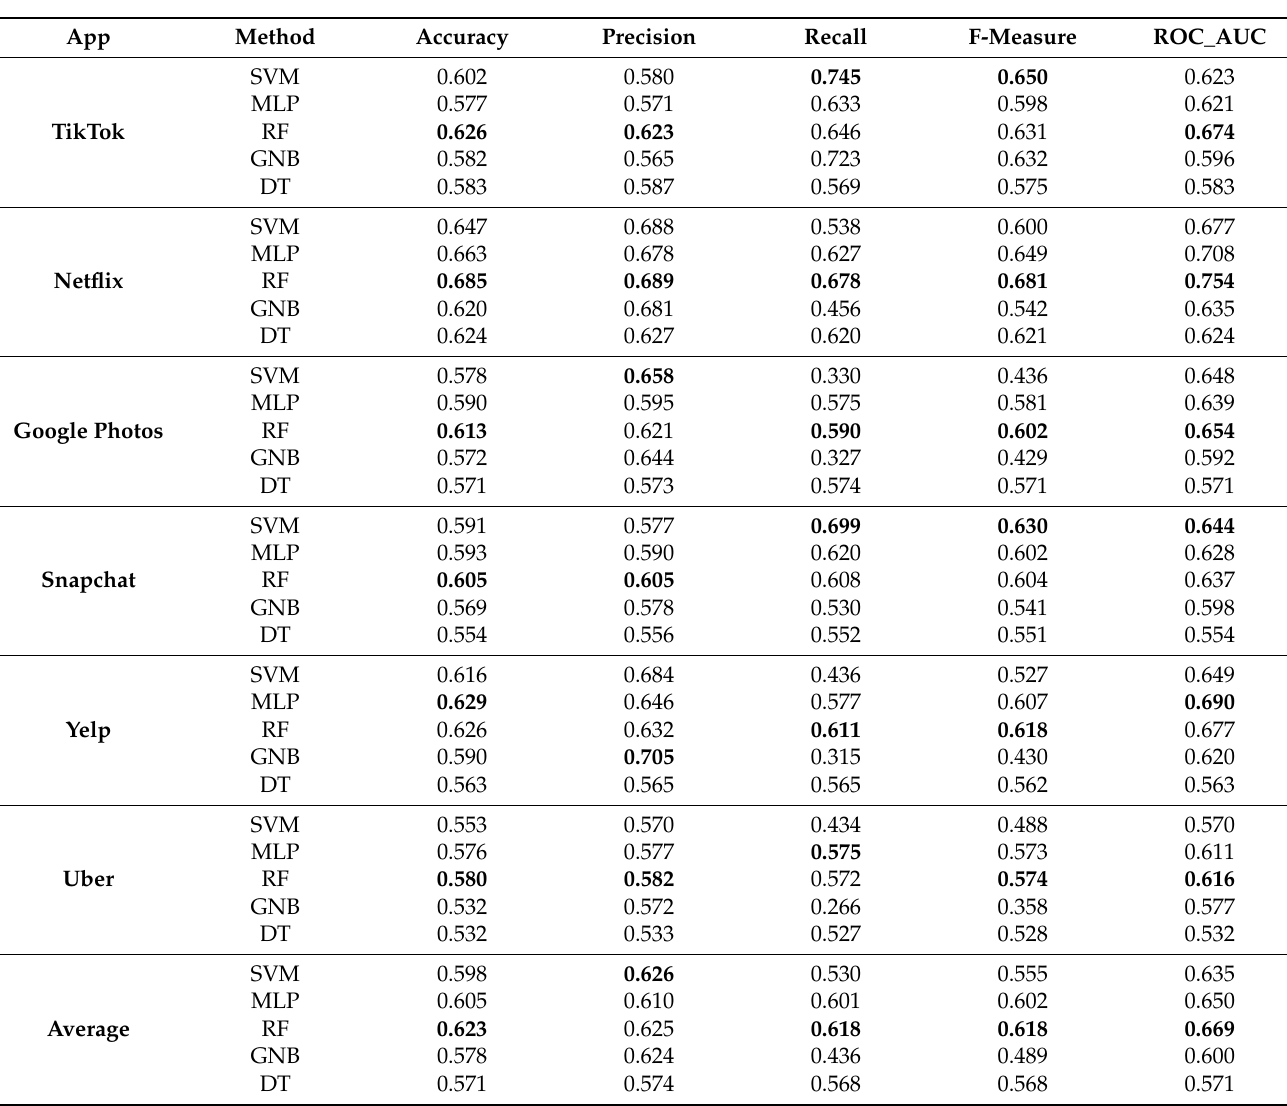
Table 6. Performance results for different methods (the results styled in bold font are the optimal performances for the same evaluation